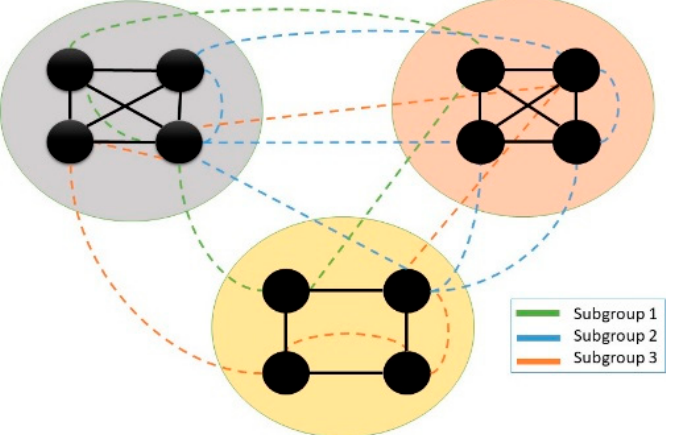
Figure 1. An example of hidden community structure. The solid black lines show the relationship among the nodes of dominant communities and the colored dotted lines represent the weaker communities.